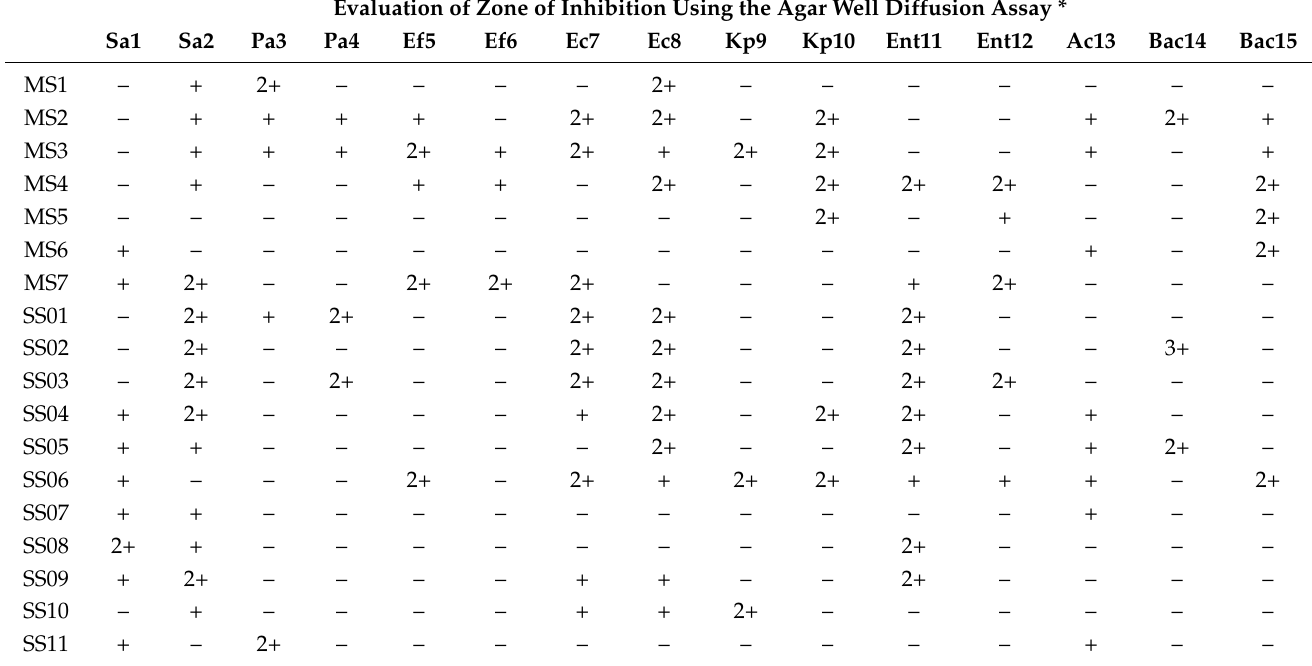
Table 11. Evaluation of the antagonistic effect of various neutralized cell-free supernatants of probi- otics and other beneficial microbes against clinical skin pathogens using the agar well diffusion assay. Evaluation of Zone of Inhibition Using the Agar Well Diffusion Assay